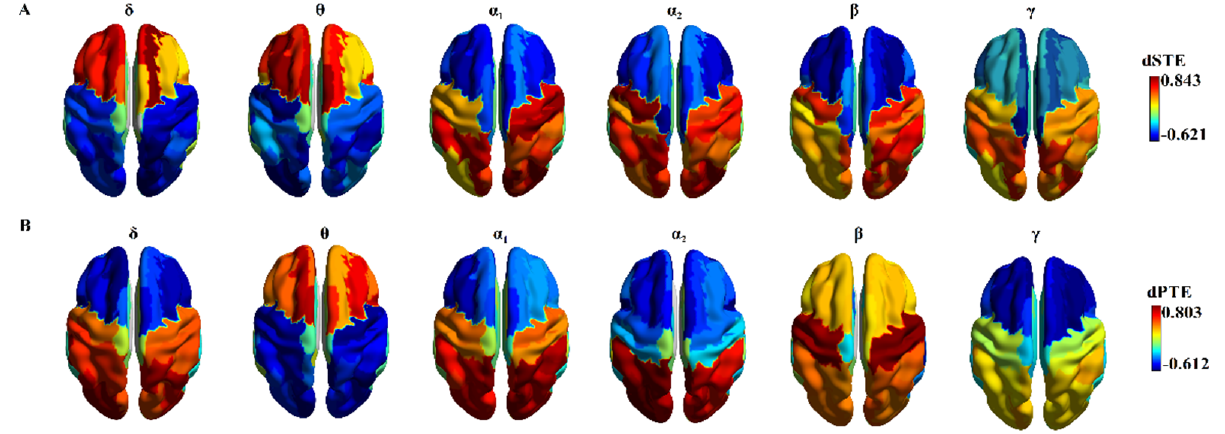
Figure 4. The mean dSTE for each ROI is displayed as a color map across the cortical areas for ( A ) mean amplitude and ( B ) mean dPTE for each ROI displayed as a color phase-oriented information flow. These topographies were stable across temporal segments, revealing a posterior-to-anterior information flow of the phase dynamics in { α 1 , α 2 , β , γ } and an opposite pattern of anterior-to-posterior information flow in θ . Concerning amplitude dynamics, a posterior-to-anterior information flow in { α 1 , α 2 , γ }, a sensory-motor β -oriented pattern, and an anterior-to-posterior pattern in { δ , θ } were revealed. Table 2. Subject-averaged PAI time-lag estimation between posterior–anterior cortical areas based on dSTE.